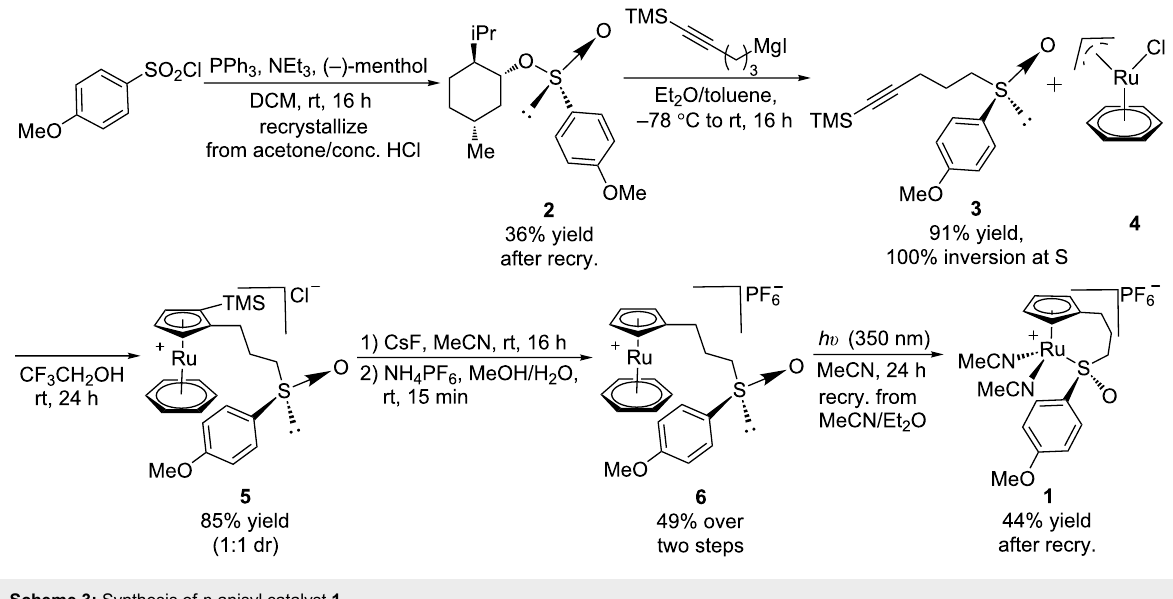
length via stereospecific nucleophilic displacement of the chiral auxiliary with complete inversion of configuration at the sulfur center [46,47]. Sulfoxide 3 is incorporated into the catalyst via a [3 + 2] oxidative cycloaddition with allylruthenium complex 4 . Desilylation of cationic complex 5 , ion exchange, and photoly- sis of 6 completes the synthesis of catalyst 1 . Using this strategy, a variety of catalysts including p -tolyl, 2-naphthyl, 1-naphthyl, and tert -butyl sulfoxide complexes were all synthe- sized in an analogous fashion. This method has a distinct advan- tage over a traditional CpRu catalyst synthesis in that the com- plexes can be made quickly and efficiently without relying on toxic thallium salts to transfer substitutionally complex cyclo- pentadienyl ligands to